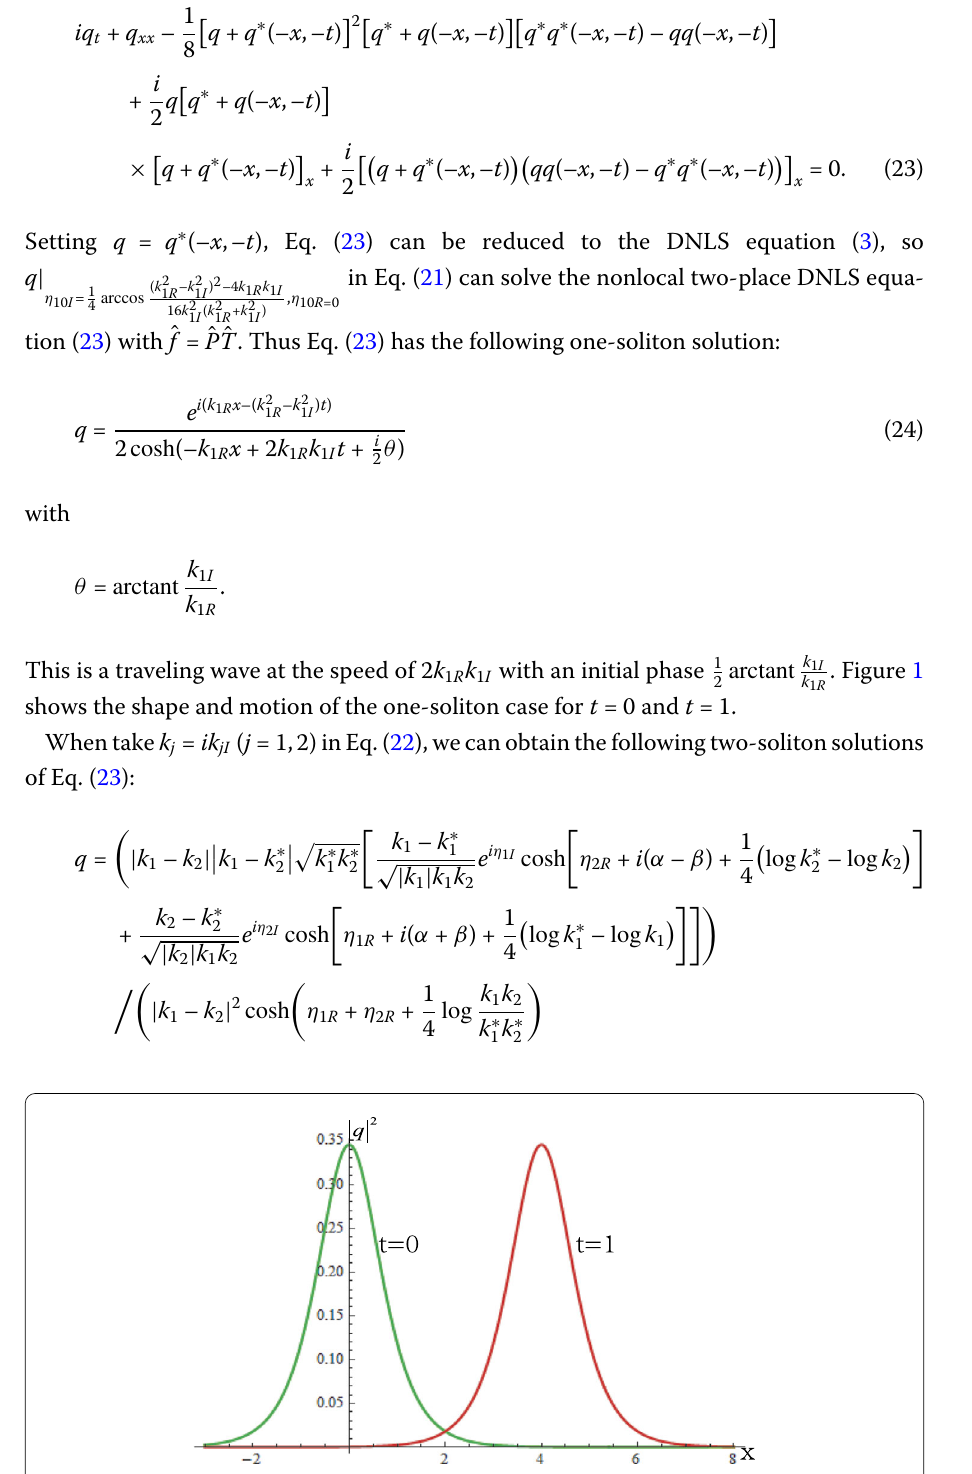
Figure 1 Motion of the one-soliton for the nonlocal two-place DNLS equation (23). The green one is the density distributions | q | 2 for t = 0 and the red one is for t = 1 with k 1 R = 1, k 1 I =